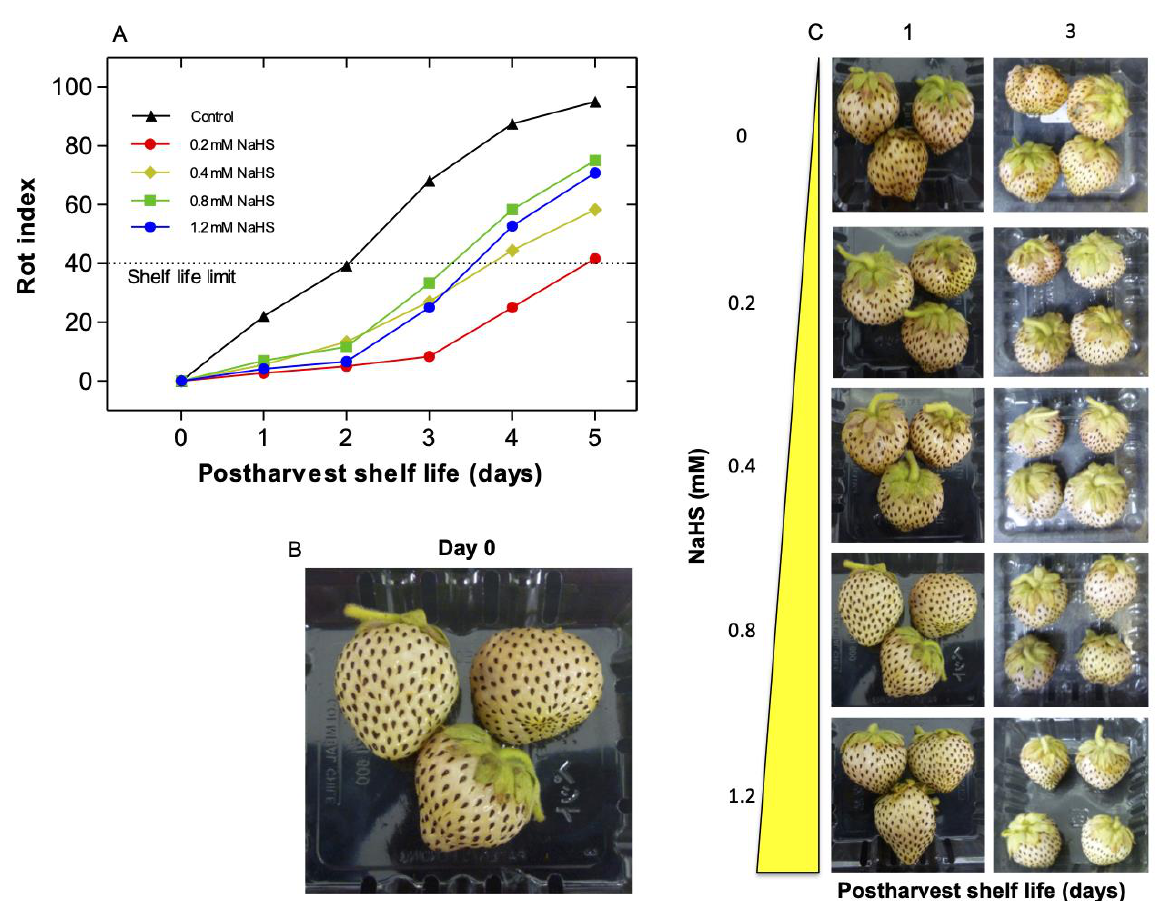
Figure 1. Effects of different H 2 S donor concentrations on rot index and appearance during postharvest shelf-life of Chilean strawberry ( Fragaria chiloensis ) fruit. Strawberries were treated after harvest with H 2 S donor NaHS at different concentrations (0, 0.2, 0.4, 0.8 and 1.2 mM). Changes in ( A ) rot index; ( B ) Appearance of strawberry fruit at harvest and ( C ) after exposure to H 2 S donor NaHS during 3 d of storage at 20 ◦